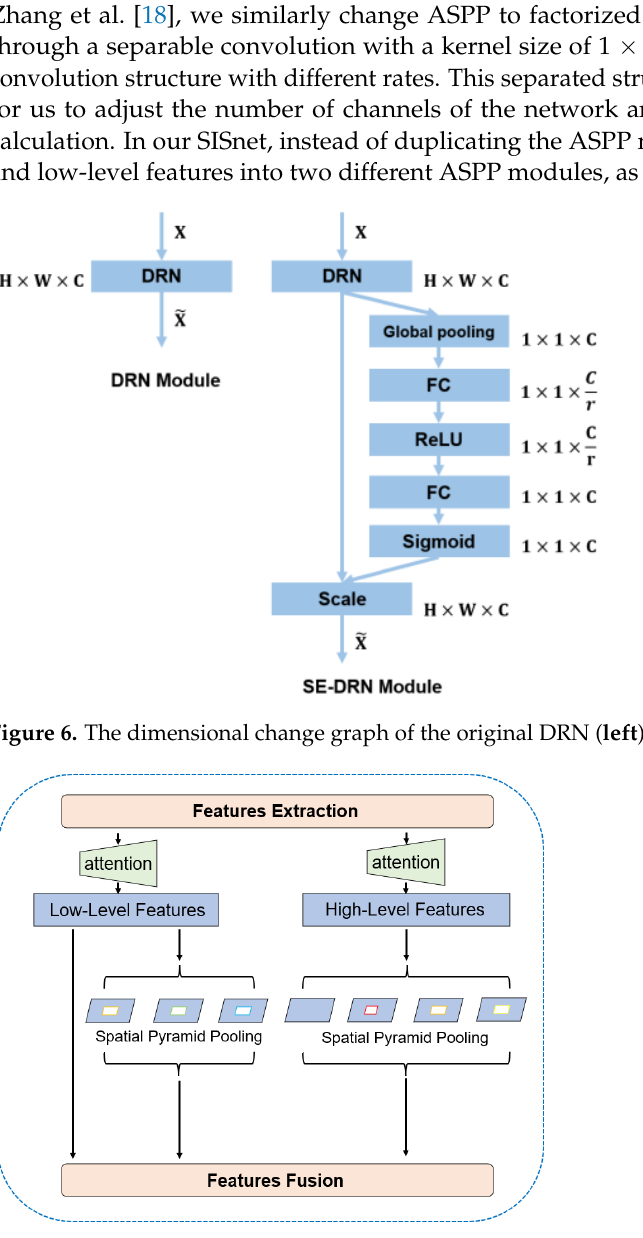
Figure 7. The schema of the parallel-ASPP structure.